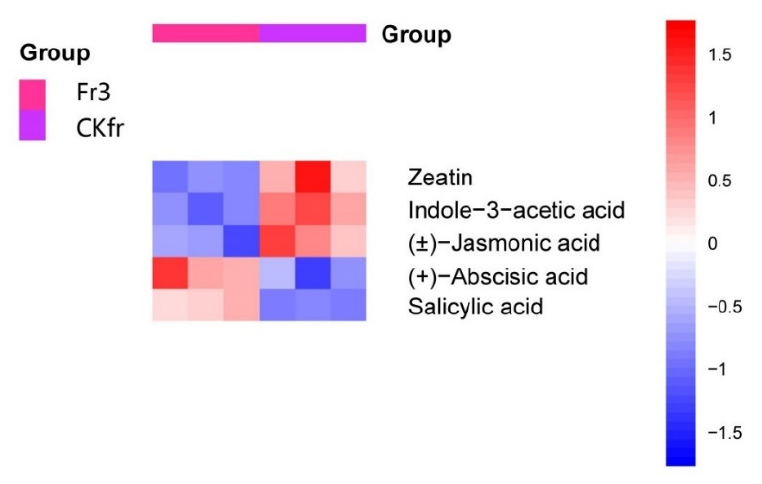
Figure 6. Heatmap of phytohormones.